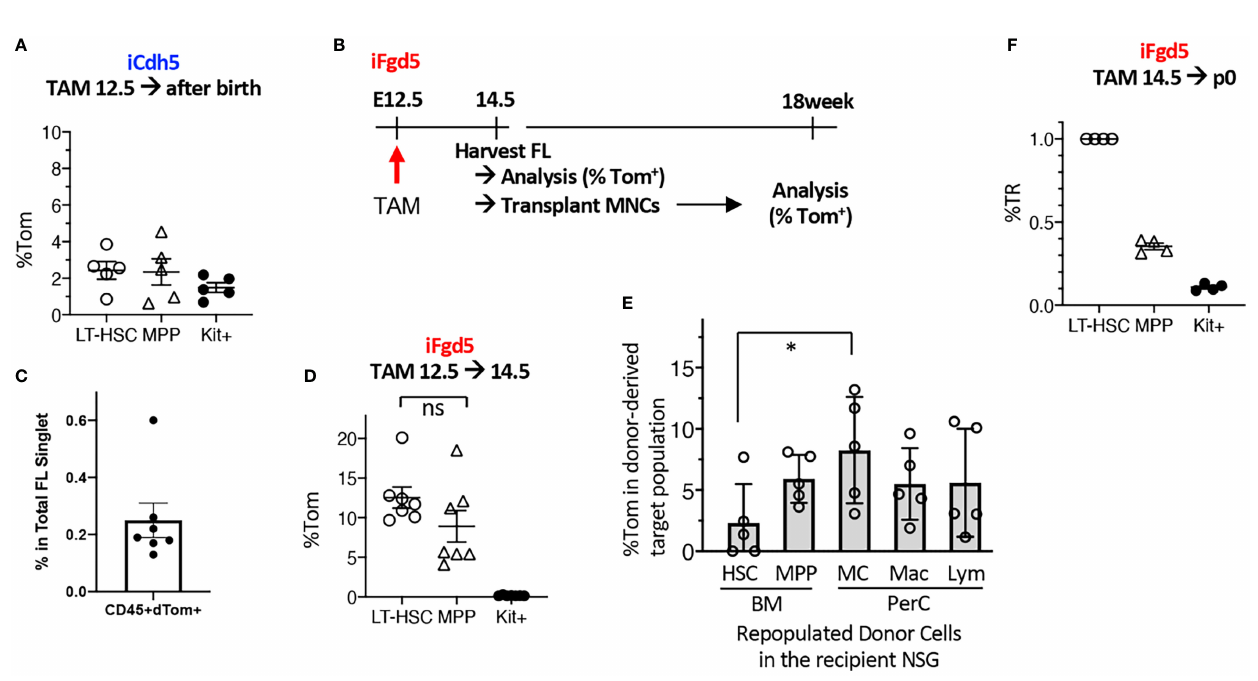
FIGURE 3 | E12.5 FL HSCs are not exclusively labeled by iCdh5 nor iFgd5. (A) TAM injections into iCdh5 embryos at E12.5 were performed and %Tom was measured in various immune lineages after birth (n=5). (B) Experimental timeline is shown. (C) TAM was injected into iFgd5 mice at E12.5 and analyzed at E14.5 FL. %Tom in LT-HSC, MPP, and Kit + are shown (n=7). (D) TAM was injected at E12.5 into iFgd5 embryo and analyzed FL at E14.5, then 4x10 5 FL MNCs from each cre (+) embryo were transplanted into adult NSG recipients, followed by lineage analysis at 18 weeks after transplant. %Tom of various fractions from recipients (post- transplant donor cells) are shown (*: p<0.05, n=5). (E) TAM E14.5 into iFgd5 was given and measured %TR at p0 (n=4). (F) %TR of LT-HSC, MPP, and c-Kit+ cells in the P0 neonatal BM when TAM was injected at E14.5. ns, not signi fi